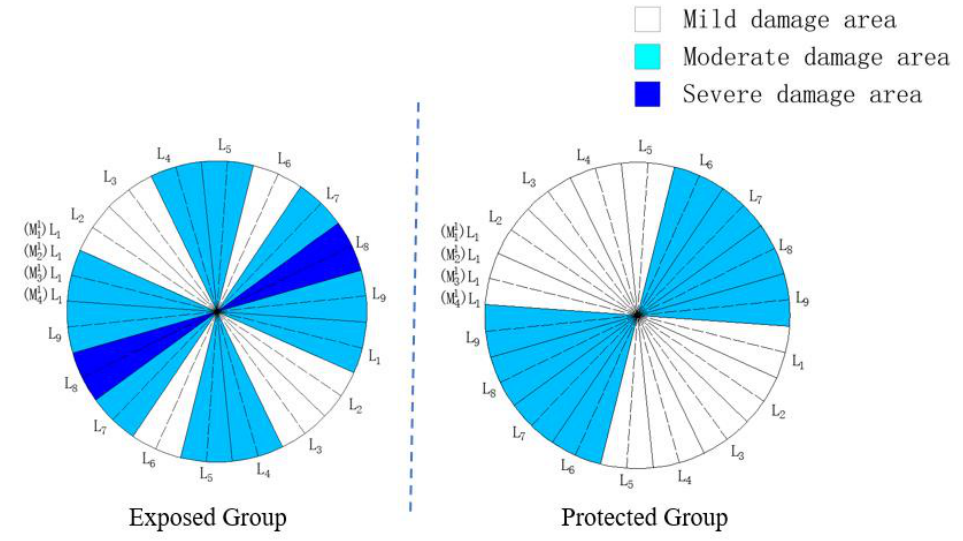
Figure 10. Damaged area division of exposed group and protected